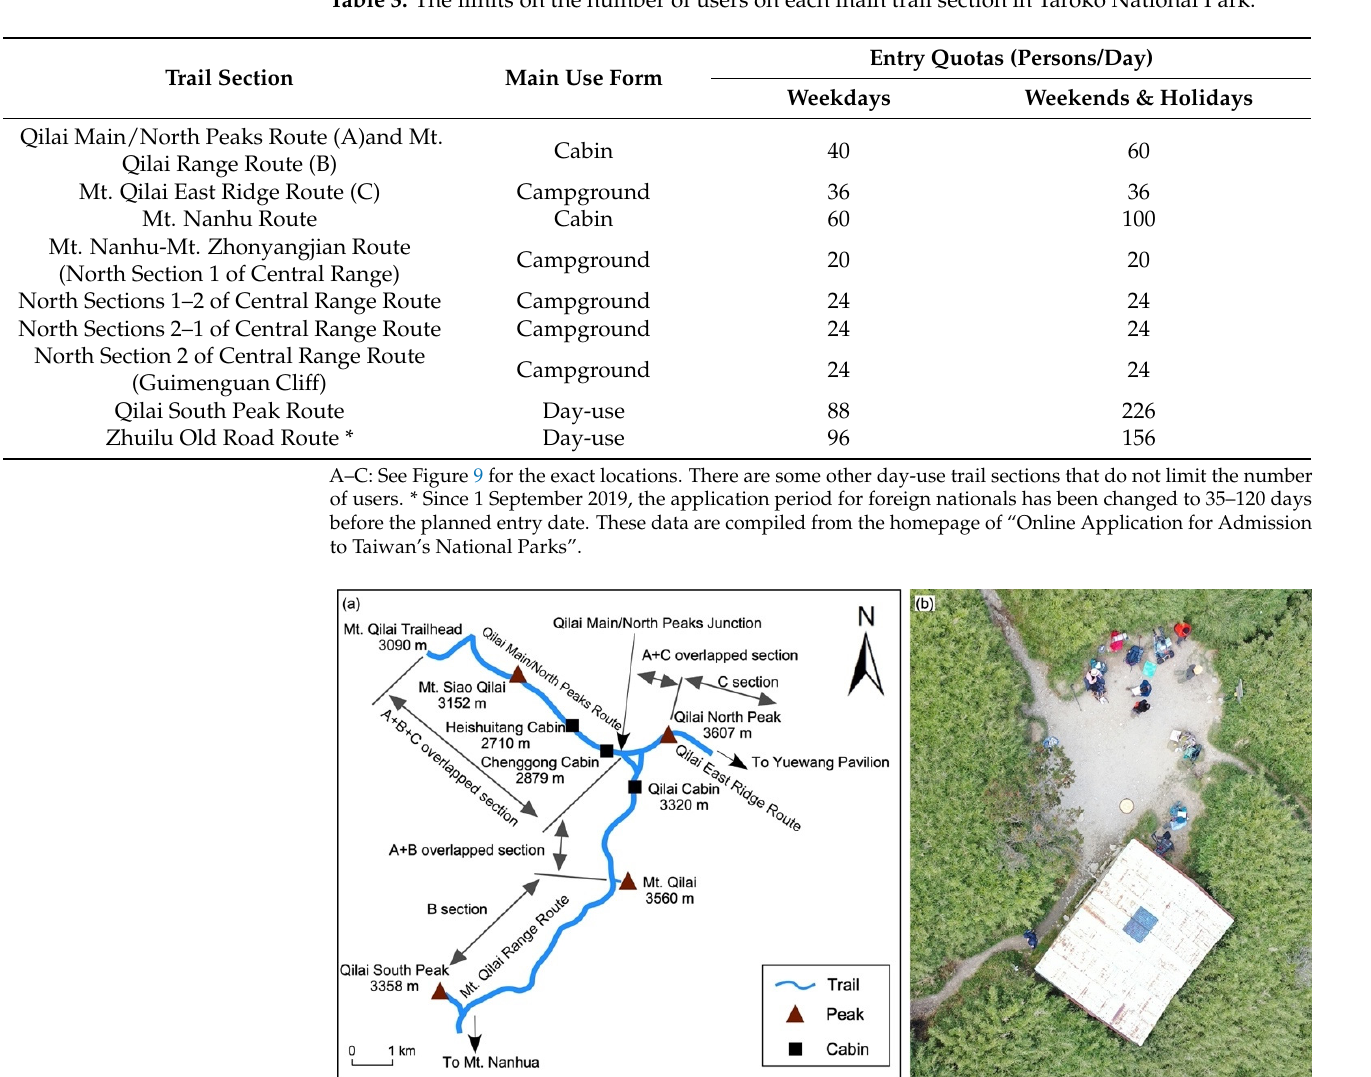
Figure 9. The “overlapped section” of the western part of the Mt. Qilai East Ridge Route in Taroko